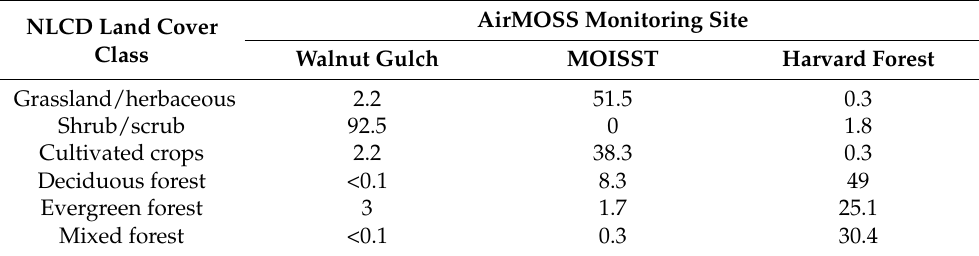
Table 1. Distribution of NLCD land cover classes at every AirMOSS monitoring site (%) (in relation to the total of all processed pixels after filtering).